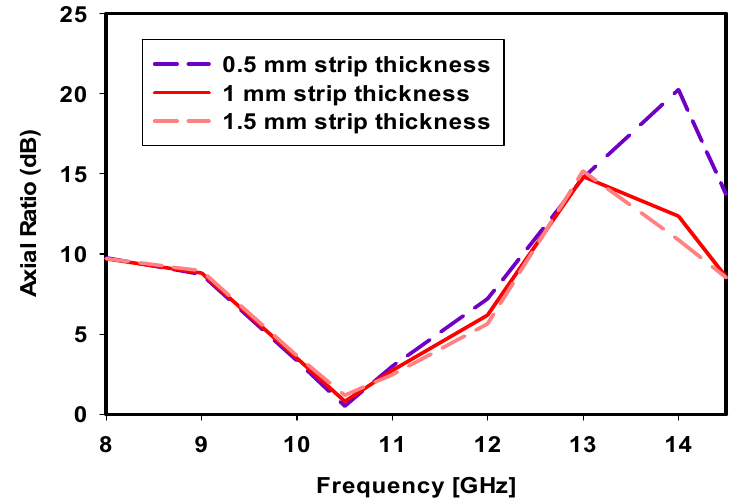
Figure 8. Effect of variation in the copper strip on the axial ratio.